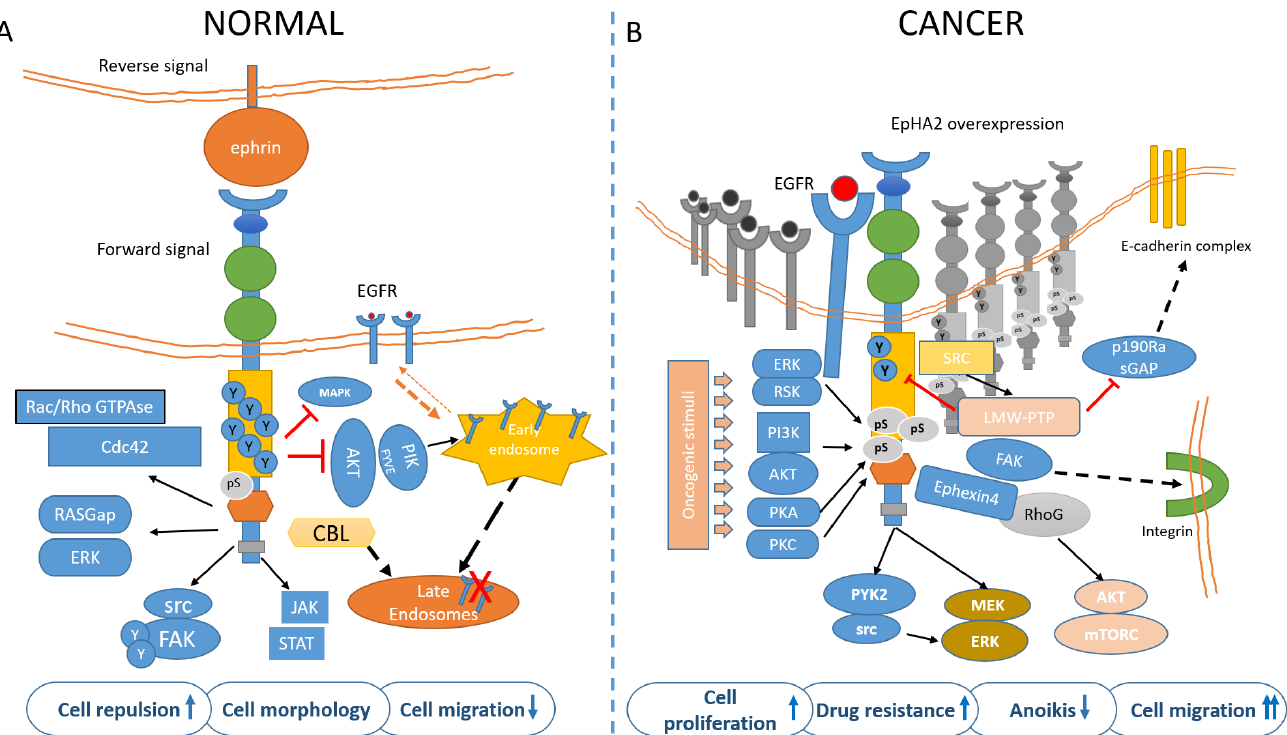
Figure 2. EphA2 signaling in normal ( A ) and cancer ( B ) cells. ( A ) In untransformed cells, EphA2 is engaged by its ligands, mainly EphrinA1 and highly tyrosine-phosphorylated. This mediates cell adhesion/repulsion through activation of Rac/Rho GTPAses and RASGap. Ligand binding also mediates inhibition of MAPK and AKT. Upon ligand binding, the EphA2 is targeted to endosomes in a CBL-mediated process. ( B ) In cancer cells, unliganded and overexpressed EphA2 is mainly phosphorylated in ser897 by PI3k/AKT, ERK/RSK, PKA, and PKC, in response to oncogenic stimuli The Akt- mTORC1, Raf-MEK-ERK, and Pyk2-Src-ERK signaling pathways were identified as the downstream signaling of the EphA2 non-canonical pathway. S897-phosphorylated EphA2 recruits Ephexin4 that in turn acts on RhoG to promote cell migration and anoikis resistance (this latter effect through a RhoG-AKT pathway). Further, FAK-integrin mediates cell adhesion and migration and may promote CSC features, including drug resistance (please also see Figure 3). The phospho-tyrosine content of EphA2 is also reduced by the LMW-PTPase, frequently overexpressed in cancer. The pro-tumorigenic contribution of EphA2 may thus derive from ligand independency, overexpression, reduced phospho-tyrosine content, and increased serine/threonine phosphorylation. Additionally, ligand-stimulated EphA2 negatively modulates the recycling of EGFR, by inhibiting AKT/PIKfyve, thus reducing the amount of available EGFR on the plasma membrane and migration. On the other hand, such feedback is attenuated in transformed cells, where EGFR levels in the plasma membrane are increased and this correlates with ligand independency of EphA2 and activation of motile responses to EGF.